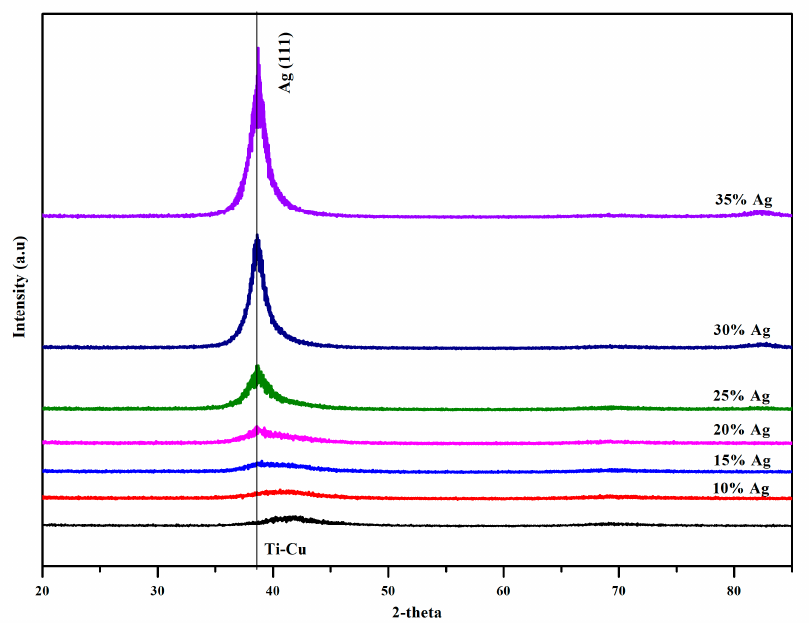
Figure 3. X-ray diffraction patterns of the Ti-Cu and Ti-Cu-Ag composite thin films on a silicon substrate with an Ag content varying between 10 and 35 at.%.